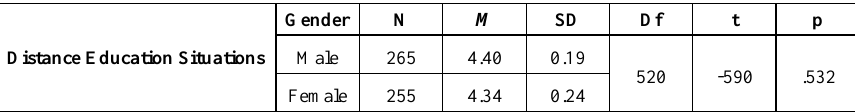
Table 7. Distance education according to gender criteria